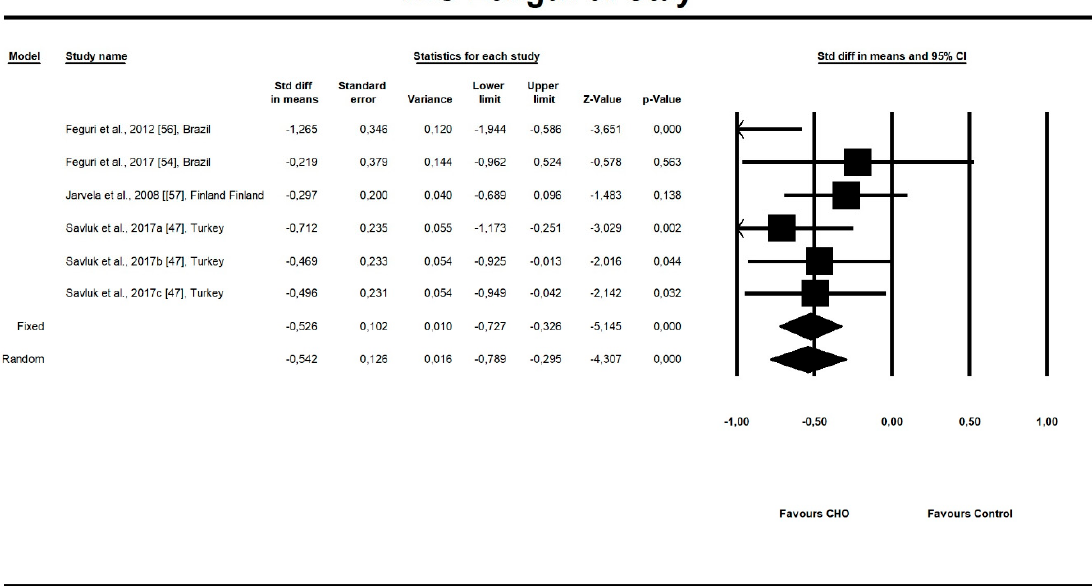
Figure 4. An e ff ect size standardized mean di ff erence, for intensive unit care (ICU) stay (hours) in Figure 4. An effect size standardized mean difference, for intensive unit care (ICU) stay (hours) in patients taking oral carbohydrates (OCH) drinks vs. controls. Std di ff in means—standardized mean patients taking oral carbohydrates (OCH) drinks vs. controls. Std diff in means ‐ standardized mean di ff erence; 95%Cl—95% confidence interval. difference; 95%Cl – 95% confidence interval.